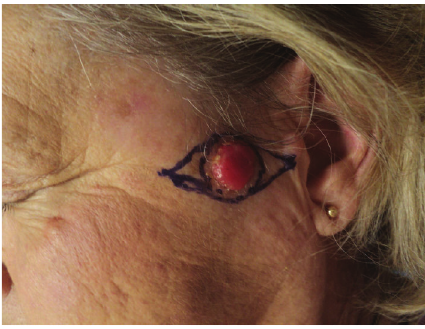
Figure 3: Recurrence of sebaceous carcinoma three months after Mohs resection.